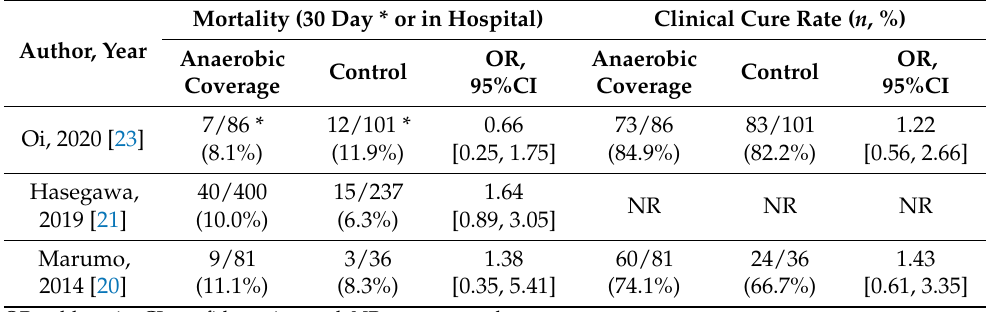
Table 2. Mortality and clinical cure rate.